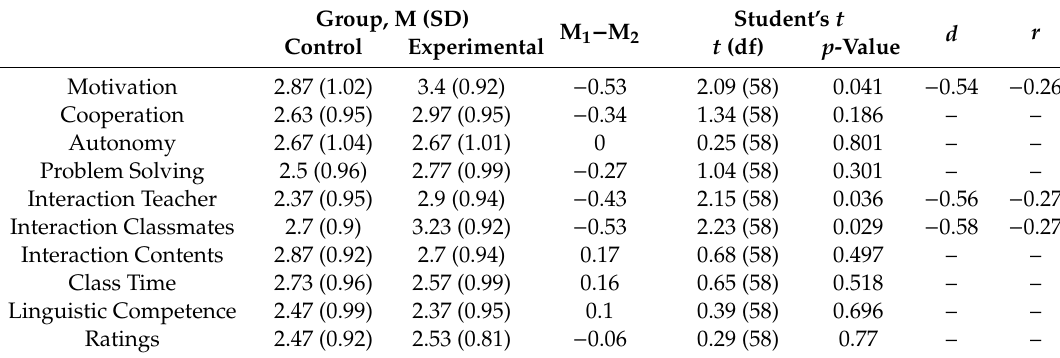
Table 3. Intergroup independence value analysis (control and